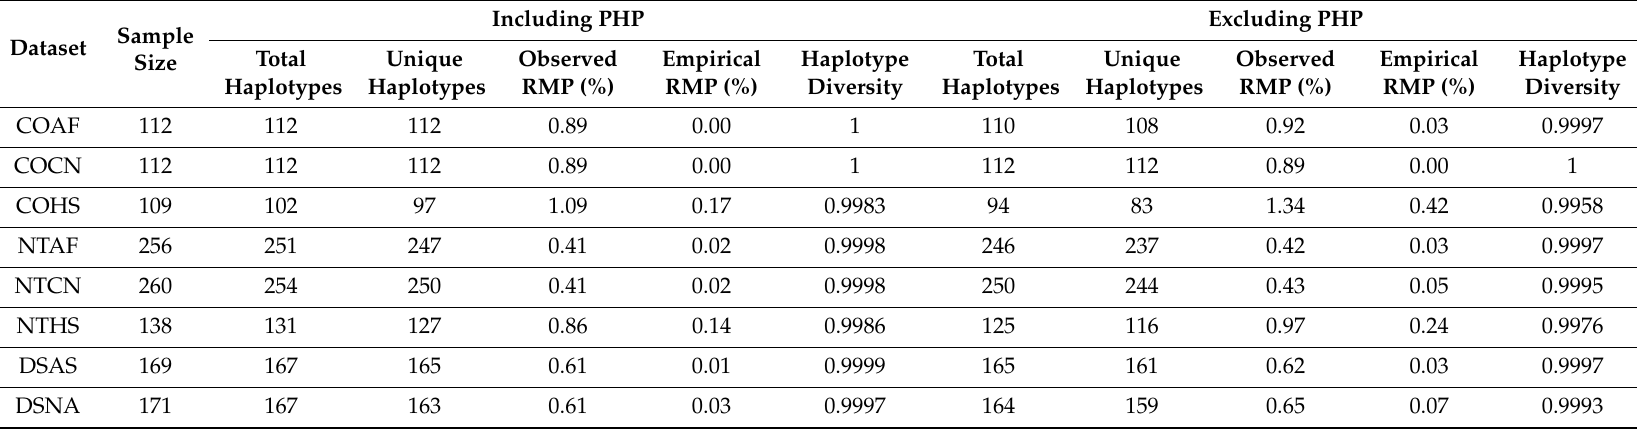
Table 6. Summary statistics. Observed and empirical random match probabilities (RMPs) and haplotype diversity were calculated for the entire mitogenome when point heteroplasmy (PHP) were included and excluded. Length heteroplasmy nps 16,193, 309, 315, 455, 463, 573, 960, 5899, 8276, and 8285 were ignored for these